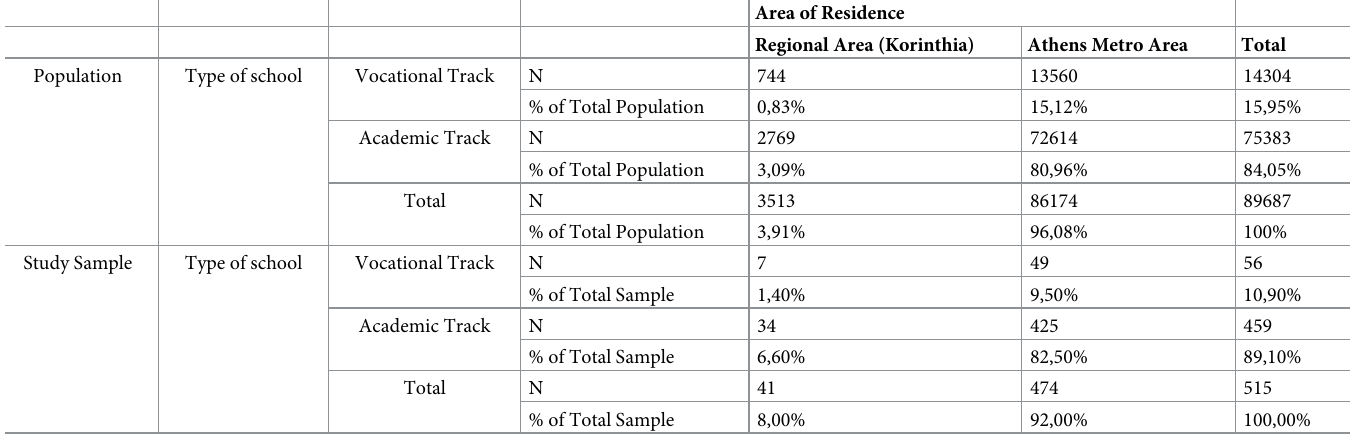
Table 1. Original population and sample